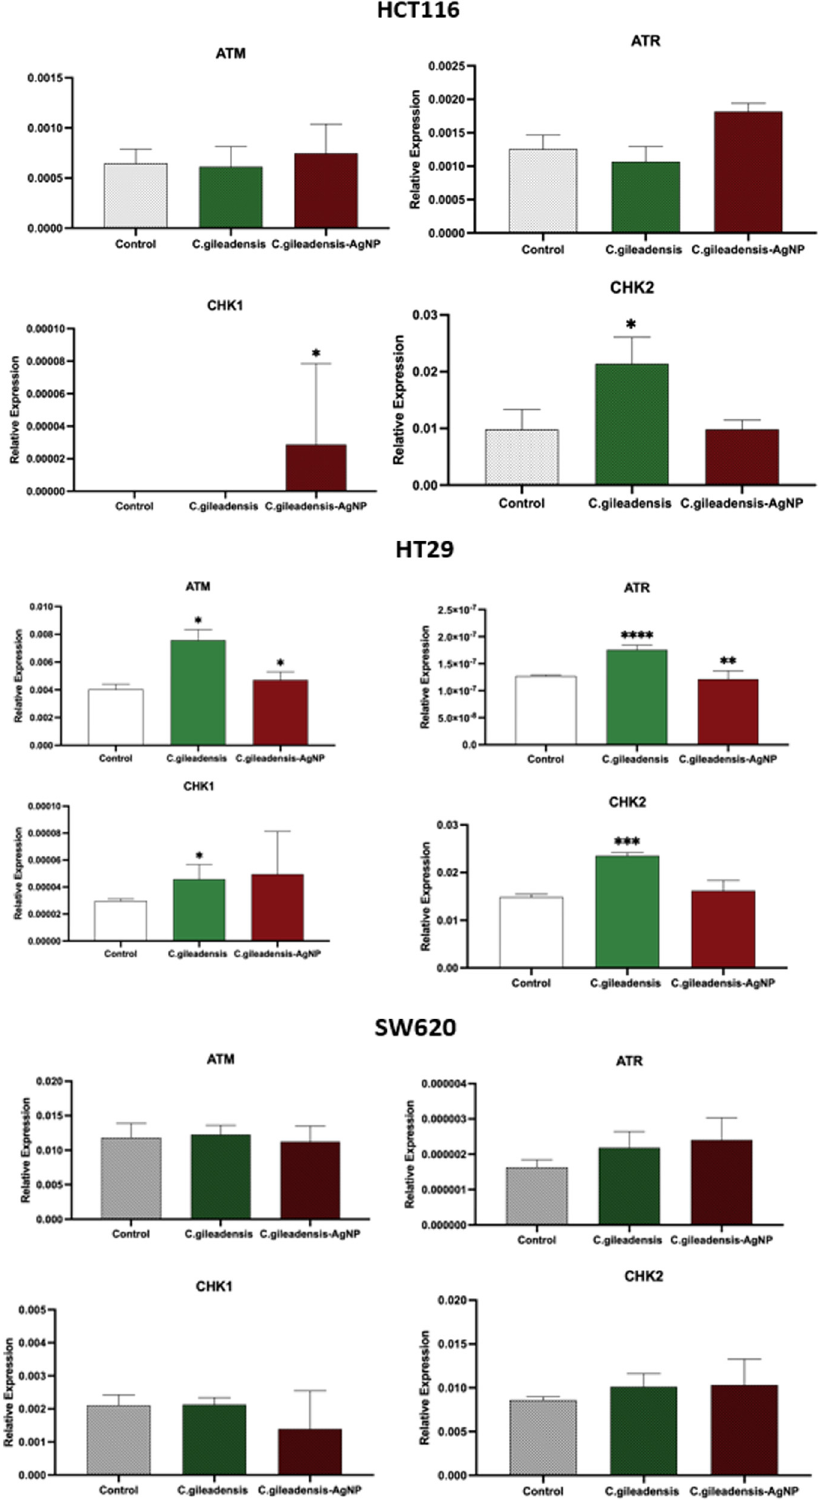
Figure 5: Gene expression fold change in cell lines treated with C. gileadensis extracts and C. gileadensis AgNPs.